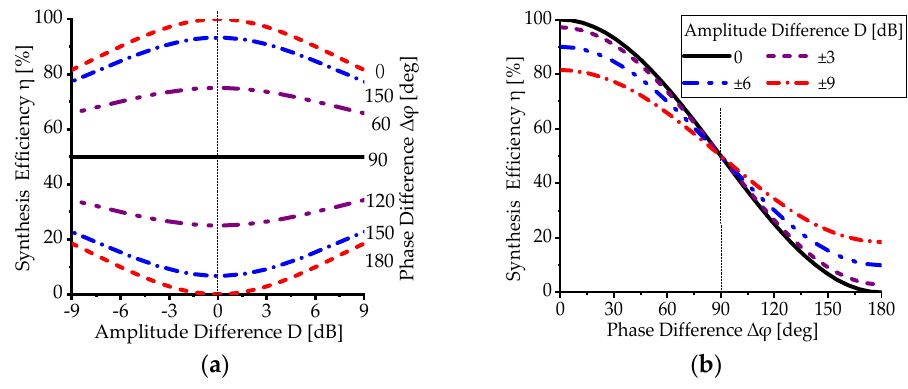
Figure 3. The influence of D and ∆ φ on the power combining efficiency η . ( a ) The influence of D on η when ∆ φ remains constant. ( b ) The influence of ∆ φ on η when D remains constant.